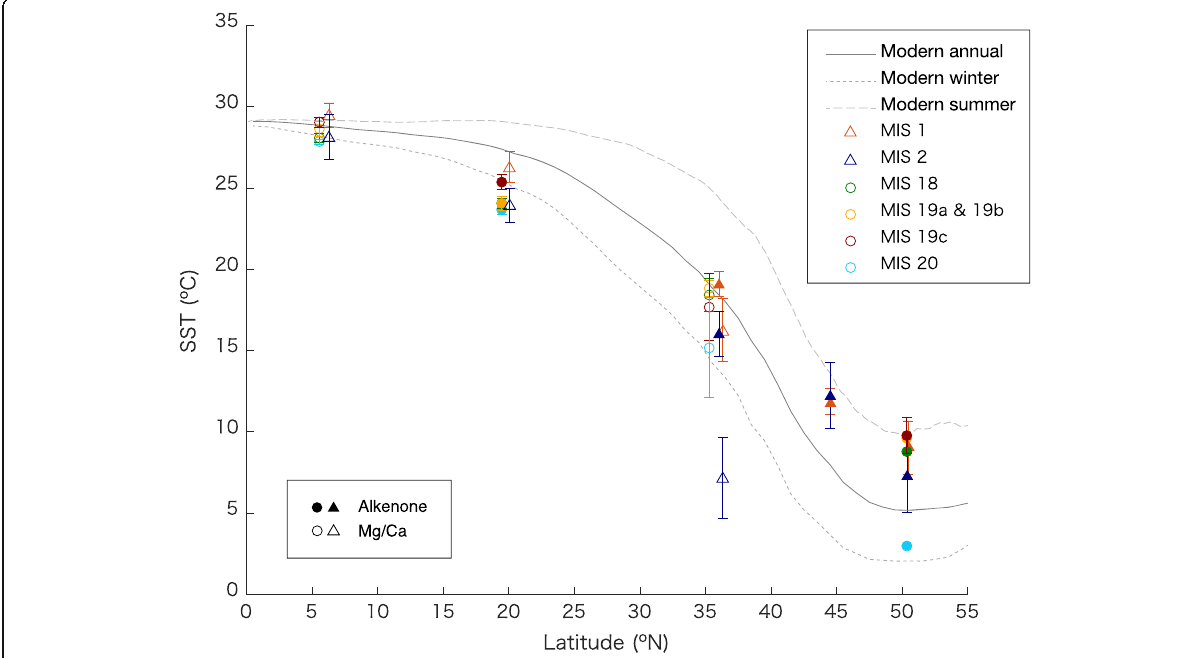
Fig. 7 Latitudinal sea-surface temperature (SST) plot of the western North Pacific listed in Table 2 for MIS 20, 19c, 19b – 19a, 18, 2, 1, and present (Locarnini et al. 2013). Filled and open symbols represent alkenone- and Mg/Ca-based SST records, respectively. Error bars are standard deviation values listed in Table